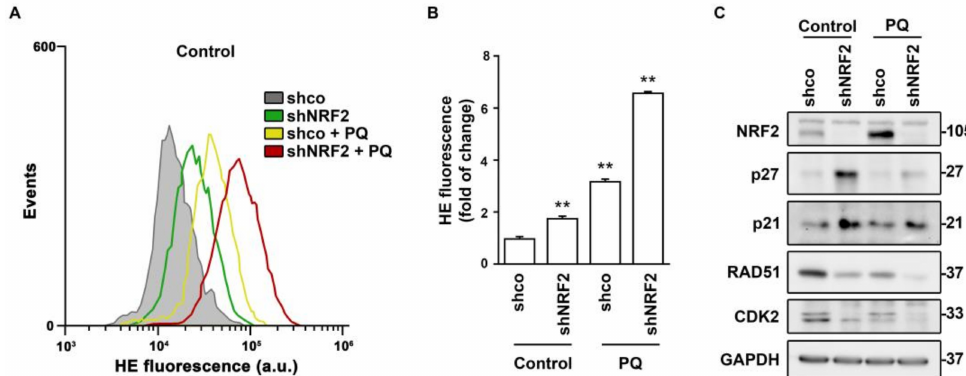
Figure 7. Regulation of cell cycle effectors by NRF2–deficiency and paraquat–induced redox dys- regulation. U–373 MG cells were transduced with lentiviral vectors containing control (shco) or shNRF2–1 (shNRF2) and treated with vehicle or 300 µ M PQ for 48 h. ( A , B ) Flow cytometry analysis of intracellular ROS production in hydroethidine (HE) stained cells. A representative sample of 10,000 cells is shown for each condition. Data are presented as mean ± S.D. ** p ≤ 0.01 according to